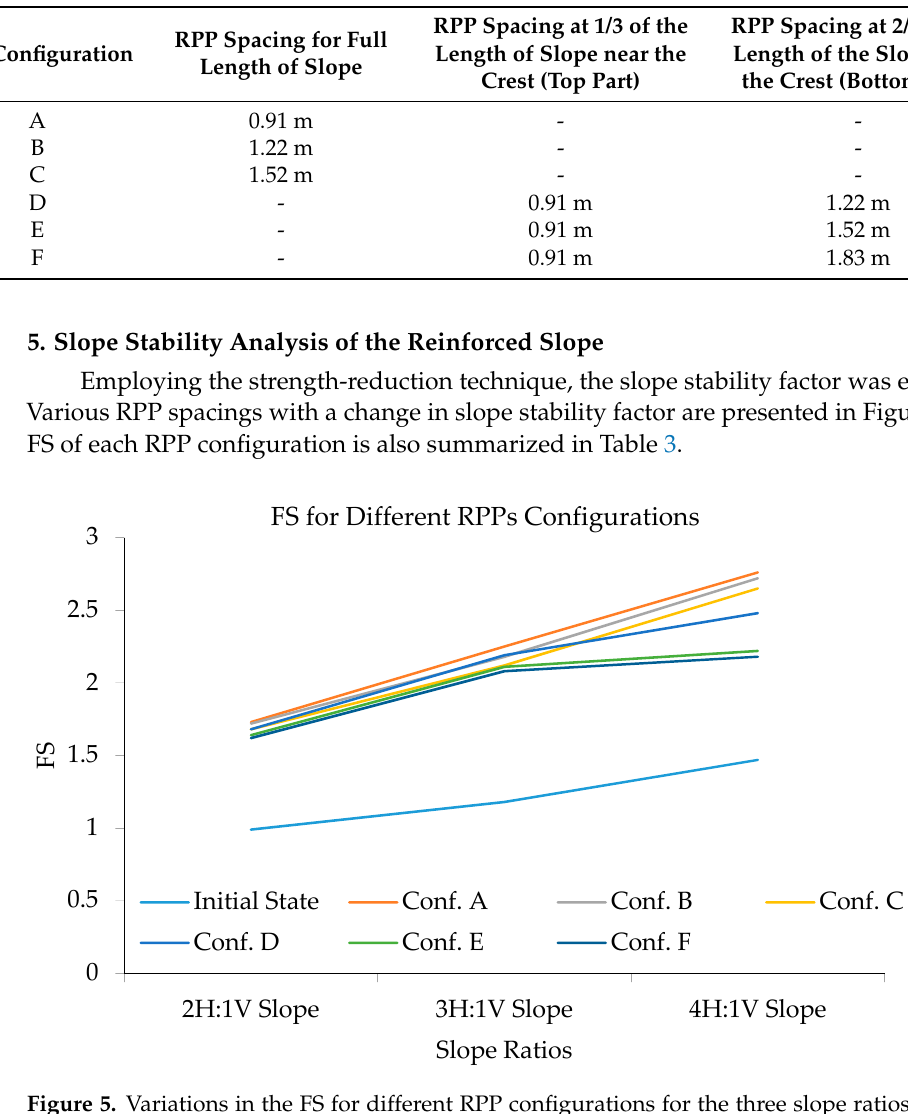
Table 2. Numerical modeling matrix.